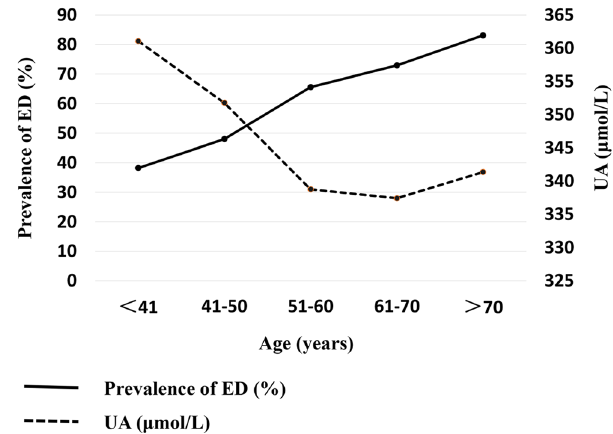
Figure 1. Changes in prevalence of ED and the concentration of UA by age groups. The horizontal axis, the left vertical axis, and the right vertical axis represent age groups, the prevalence of ED, and the serum UA concentration